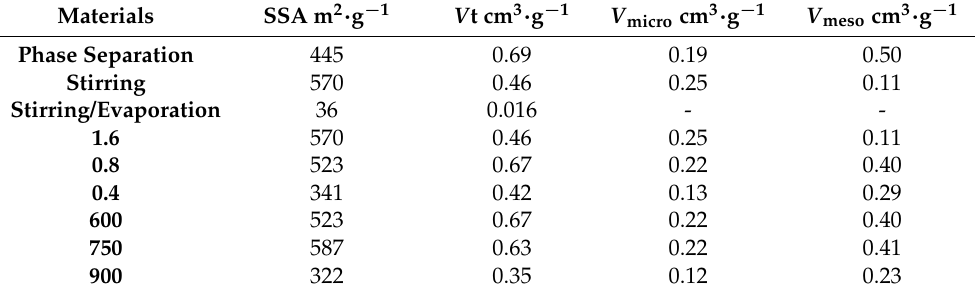
Figure 3. Nitrogen adsorption/desorption isotherms ( a ) and their corresponding 2D-NLDFT pore size distribution ( b ) of carbon materials obtained by using different synthesis procedures.